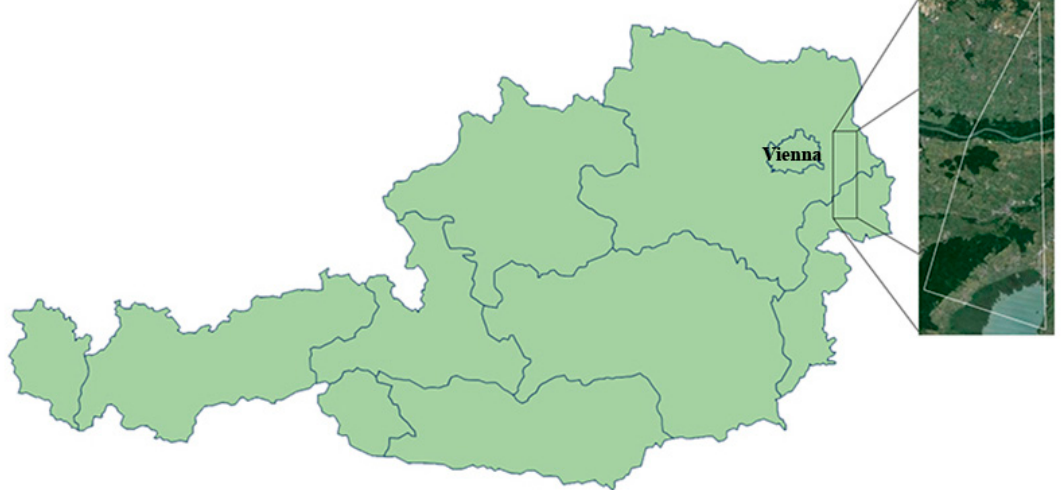
Figure 1. Map of Austria. The study site is shown in the satellite image excerpt, bordered in white. The map is modified from Google Maps.